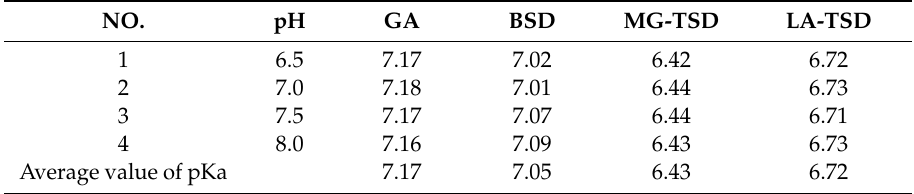
Table 3. pKa values of GA, binary solid dispersion (BSD), meglumine ternary solid